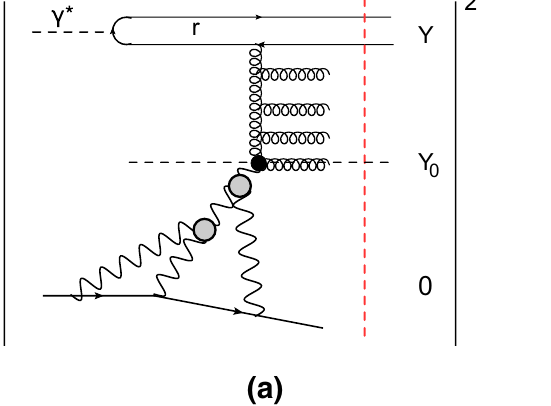
Fig. 1 The graphic representation of the processes of diffraction production in the region of high mass. The wavy lines denote the BFKL Pomerons. Y = ln